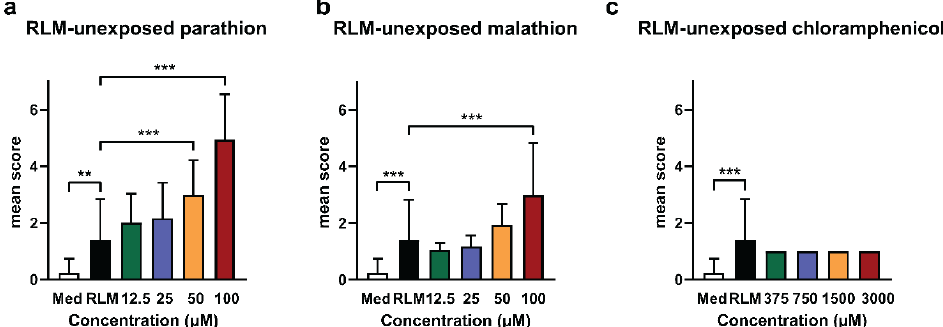
Figure 1. Mean scores of lethality and sub-lethal toxicity of test compounds unexposed to rat liver microsome (RLM) in zebrafish eleuthero embryos. The bar charts show the results after incubation of three days post fertilization (dpf) zebrafish eleuthero embryos with blank samples that were processed and spiked with different concentrations of ( a ) parathion, ( b ) malathion, and ( c ) chloramphenicol. Control conditions consisted of eleuthero embryos exposed to the RLM extract (without compound spiking) in the medium (indicated as RLM), and eleuthero embryos exposed to the medium without the RLM extract and without spiking (indicated as Med). After 48 h the incubated eleuthero embryos were morphologically screened, and the mean scores calculated, as described in methods. Three independent experiments were performed, the data were pooled and the mean ± SD was calculated. Hence, a total of six eleuthero embryos were processed per concentration, except in the case of Med samples ( n = 10) and RLM samples ( n = 10). For the statistical analysis, the mean score of RLM was compared with the mean scores of the other samples by using one-way ANOVA with Dunnett’s multiple comparison test. ** p ≤ 0.01, *** p ≤